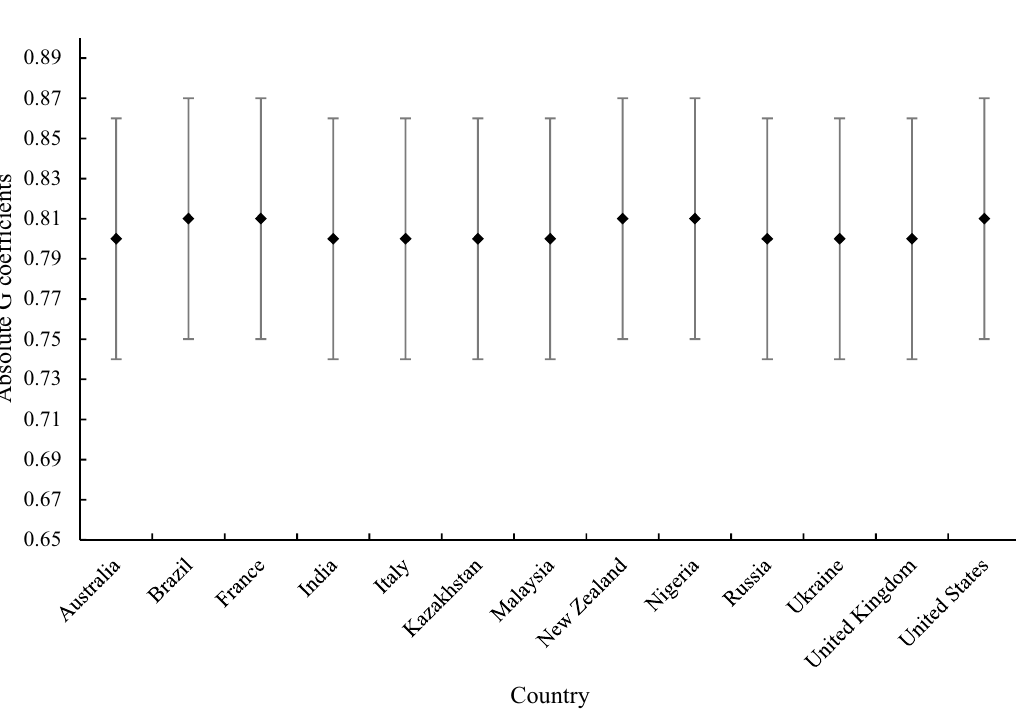
Figure 3. Graphical representation of reliability by absolute G coefficient for each country including 95% confidence